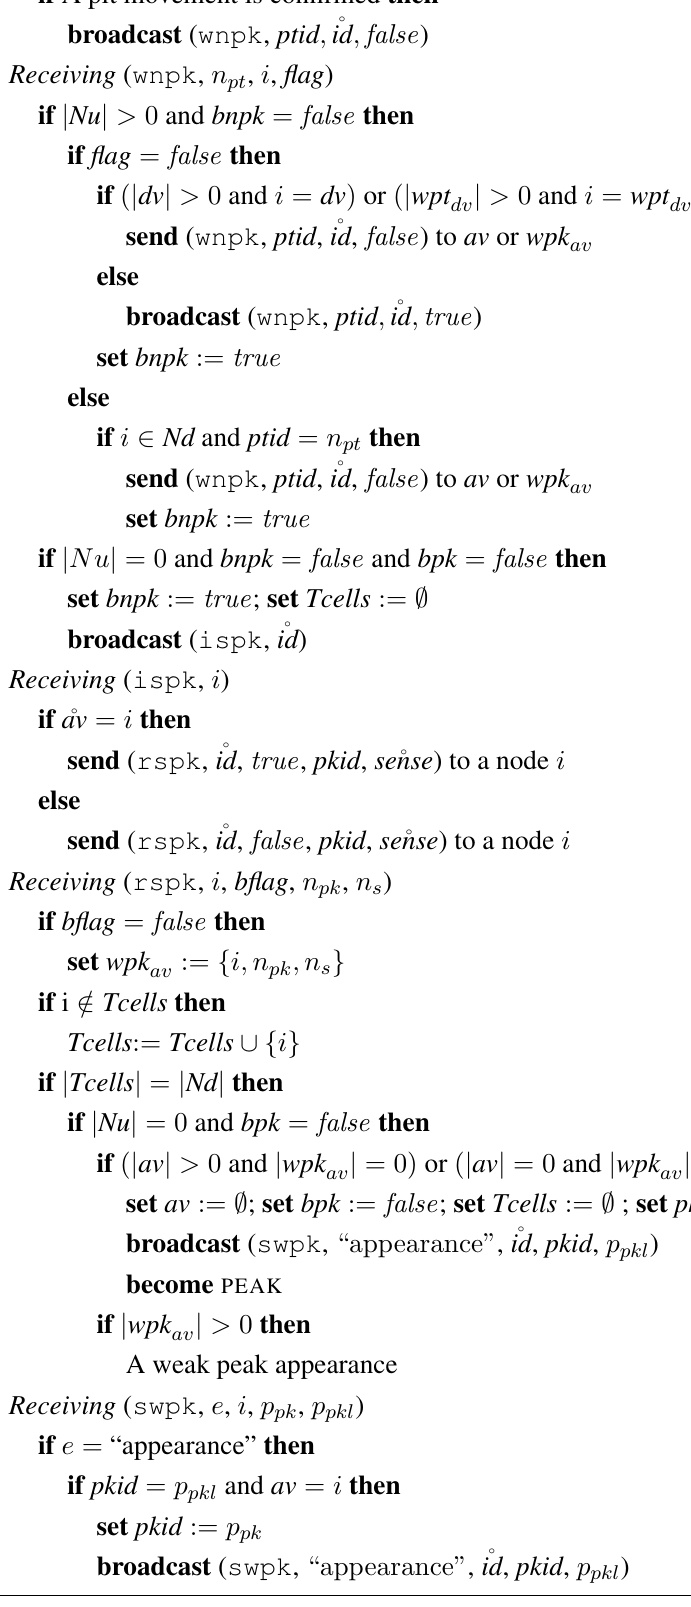
Algorithm 4 Monitoring a peak